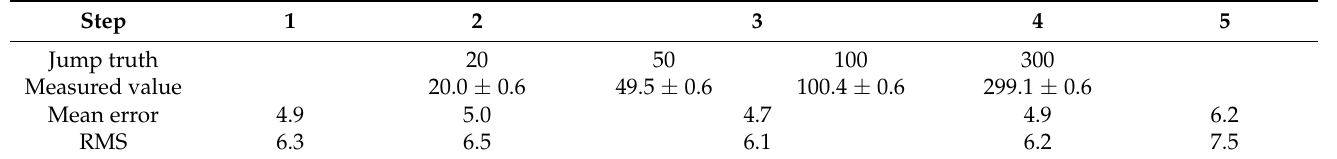
Figure 11. The picture of the step master and the display region ( a ). Measured depth map of the step master ( b ) and corresponding off-surface error ( c ) (unit: mm). Table 2. Measured result of step master ( µ